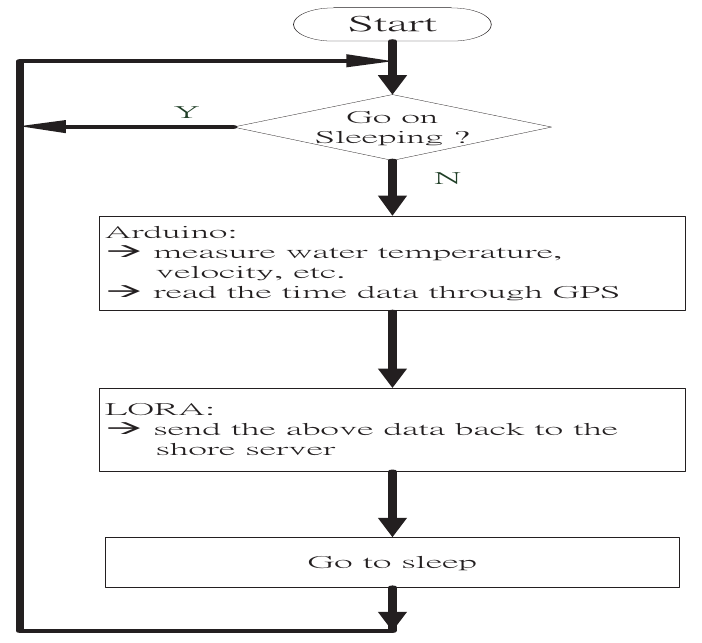
Figure 3. Operation flow of the proposed